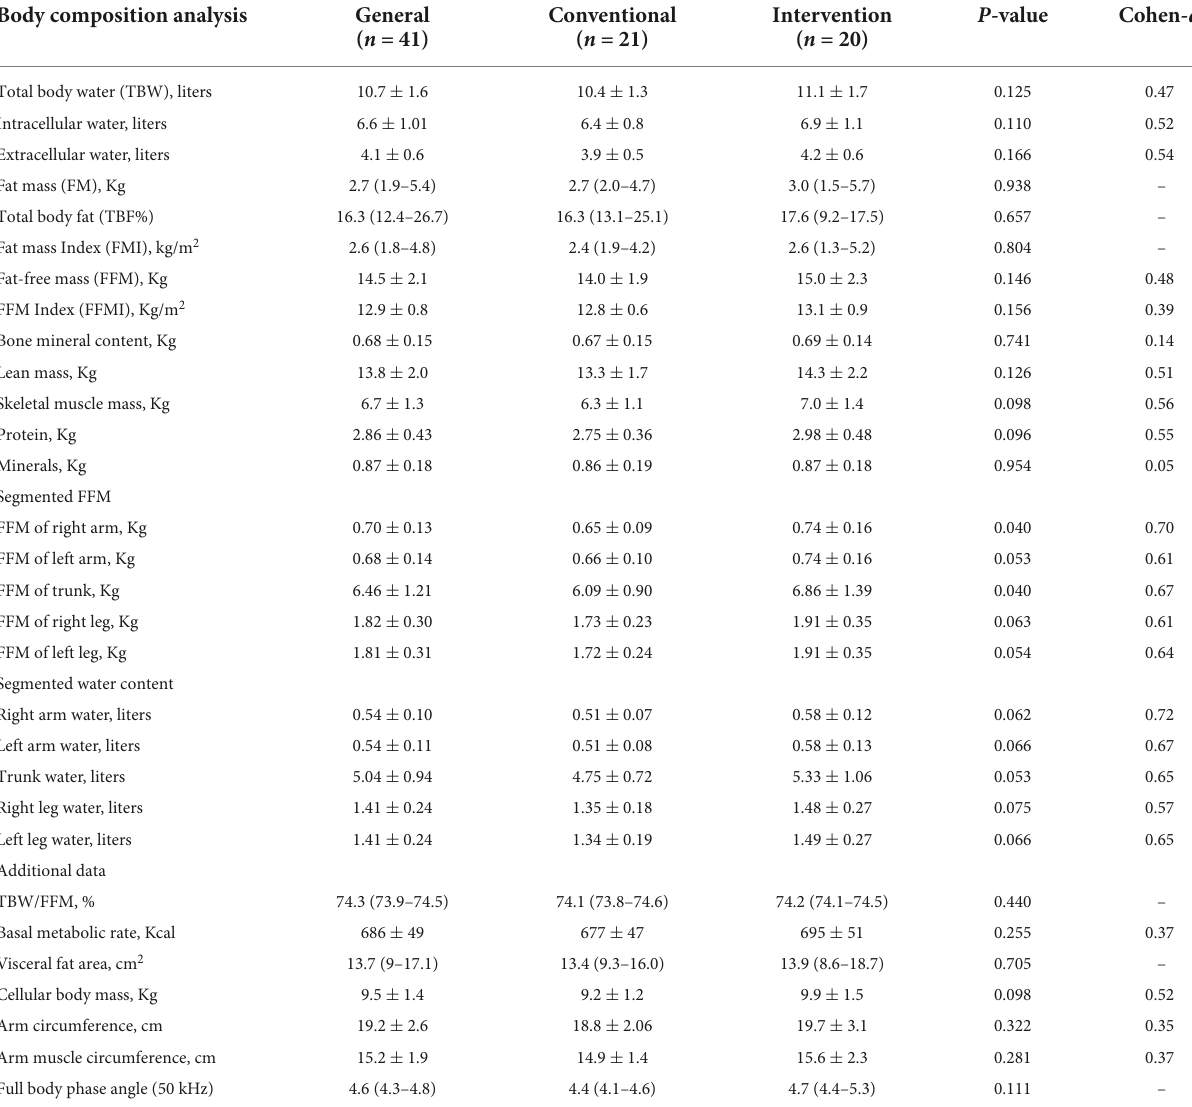
TABLE 4 Body composition in preterm infants subjected to early intervention program compared to conventional care. Body composition